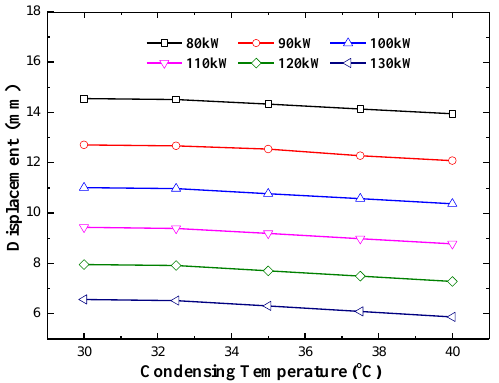
Figure 20. Displacement of suction slide valve vs. condensing temperature.